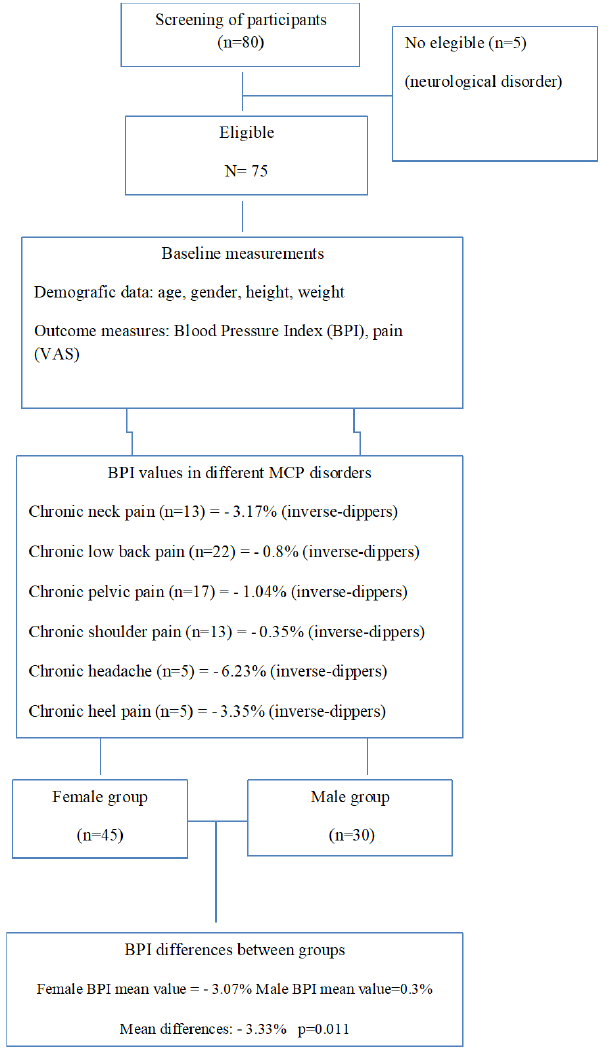
Figure 1. Flow diagram showing the recruitment procedures and the final number of patients included in this study.